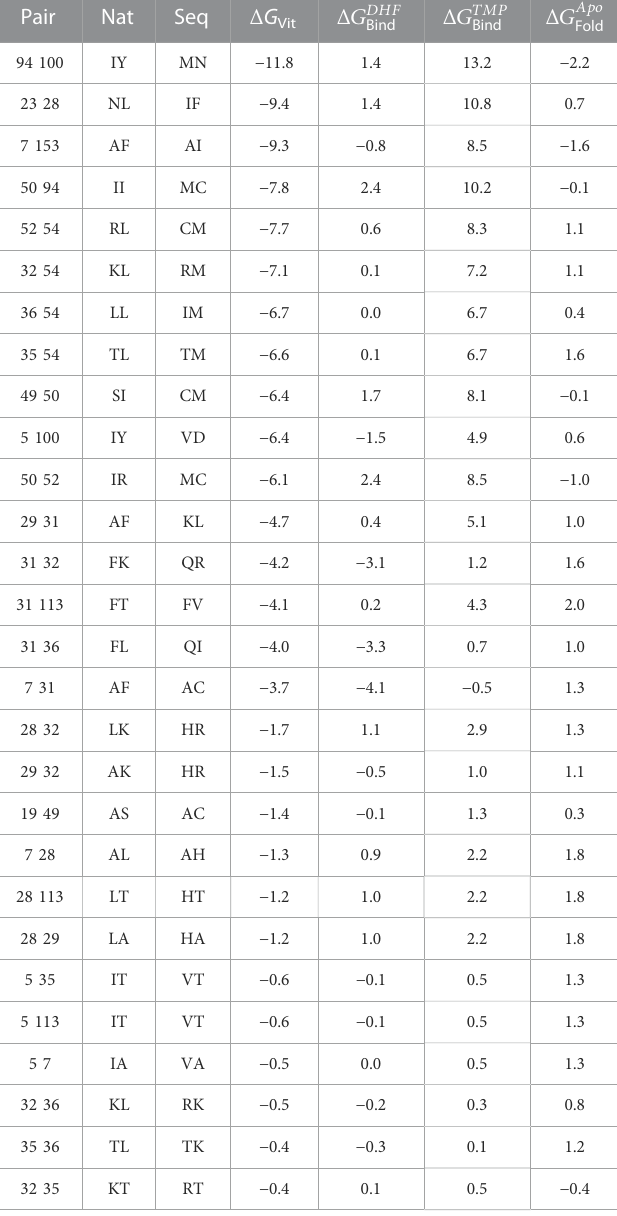
TABLE 3 Free energies (kcal/mol) from the top hits at the top 28